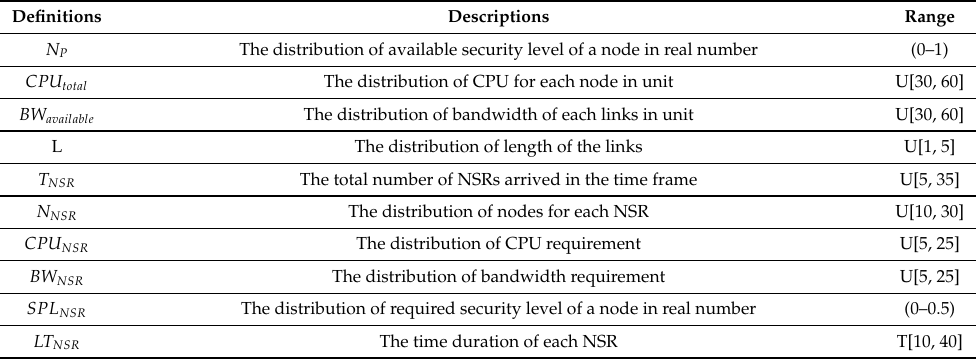
Table 3. Test case